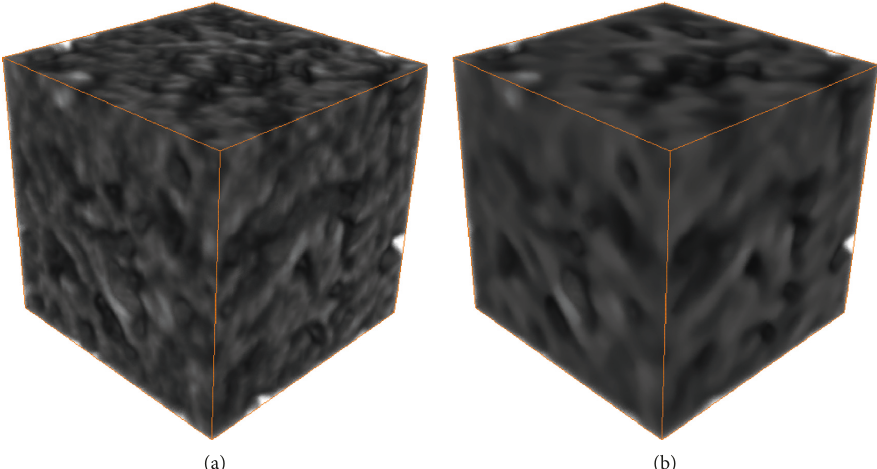
Figure 5: Comparison of the P 1 model before and after denoising: (a) before denoising and (b) after